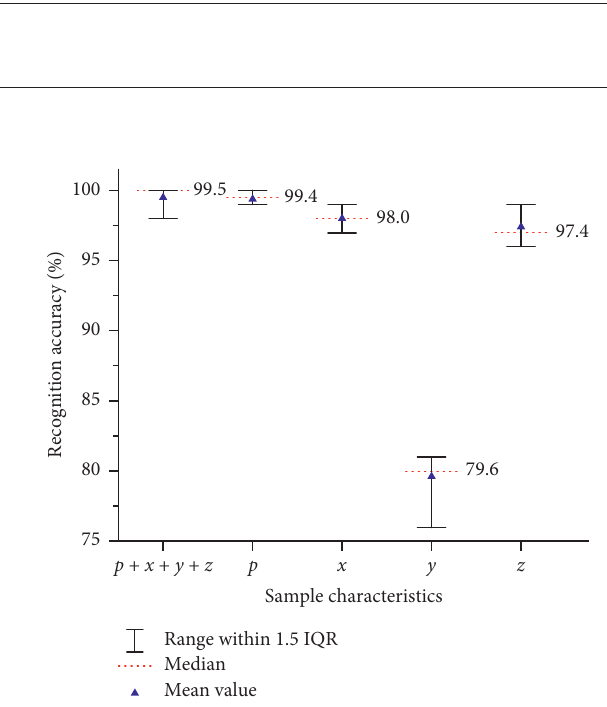
Table 6: Comparison of recognition accuracy rate of different fault diagnosis methods. Fault diagnosis